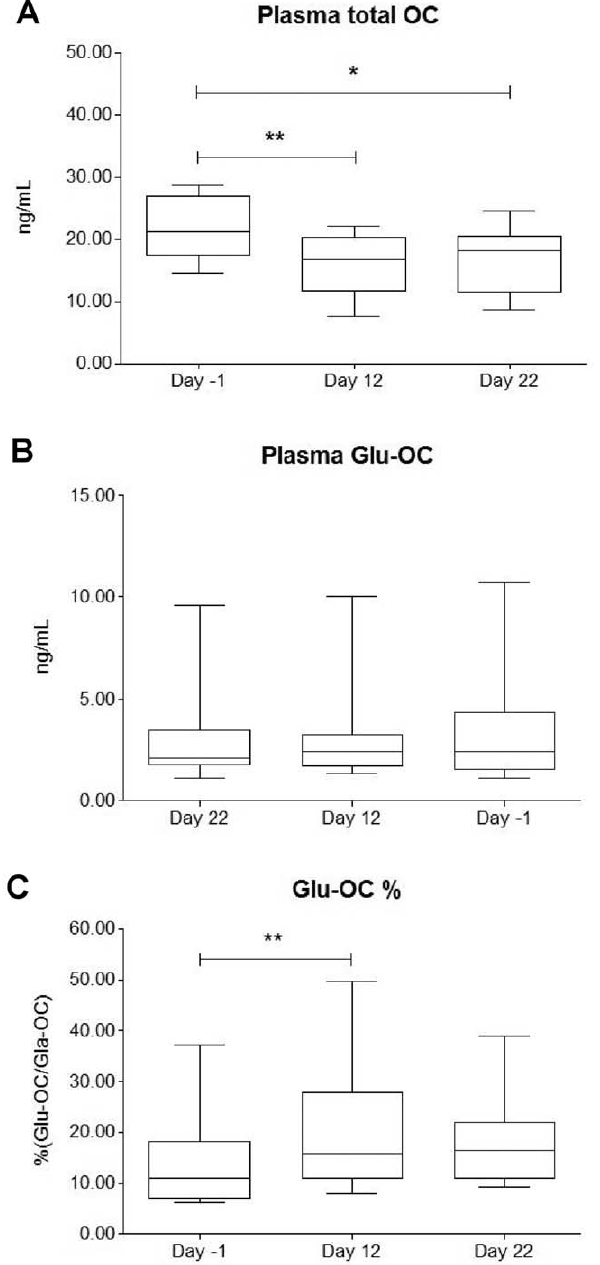
Figure 2. Modification of plasma osteocalcin levels and relative concentration of Glu-OC over the race. The Figure shows the trends of plasma total OC (panel A), plasma Glu-OC (panel B) and relative percentage concentration of Glu-OC (panel C) over the stage race. ** and * indicate significant variations (p , 0.01 and p , 0.05, respectively).